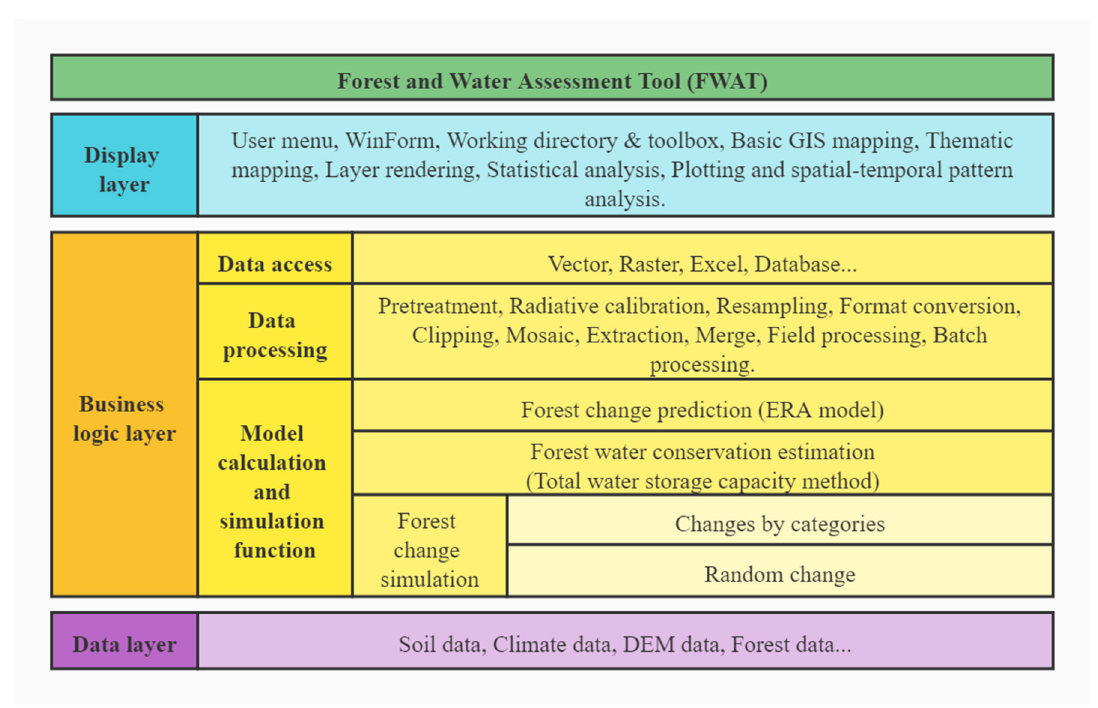
Figure 4. FWAT structure.